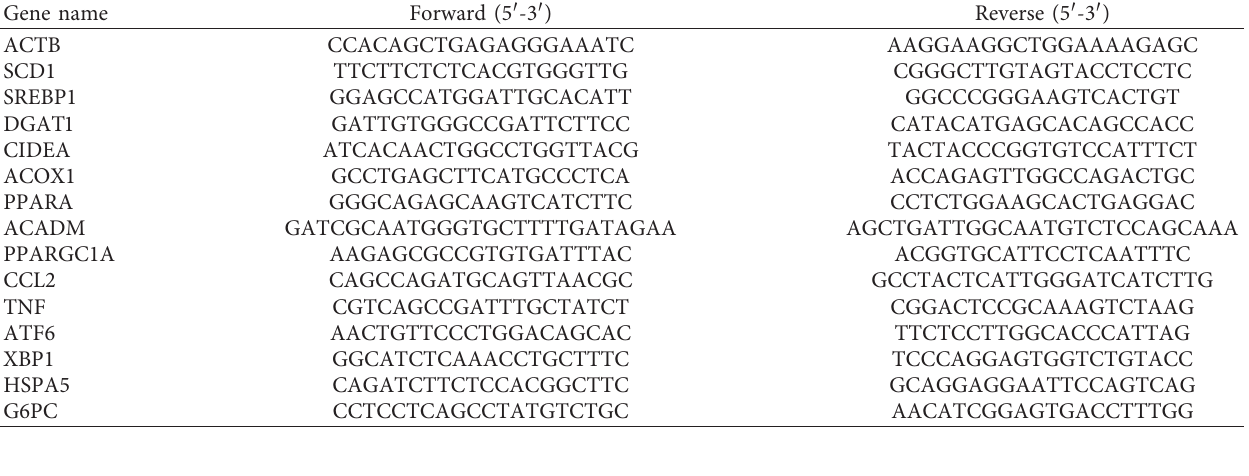
Table 1: Primer list of real-time PCR.